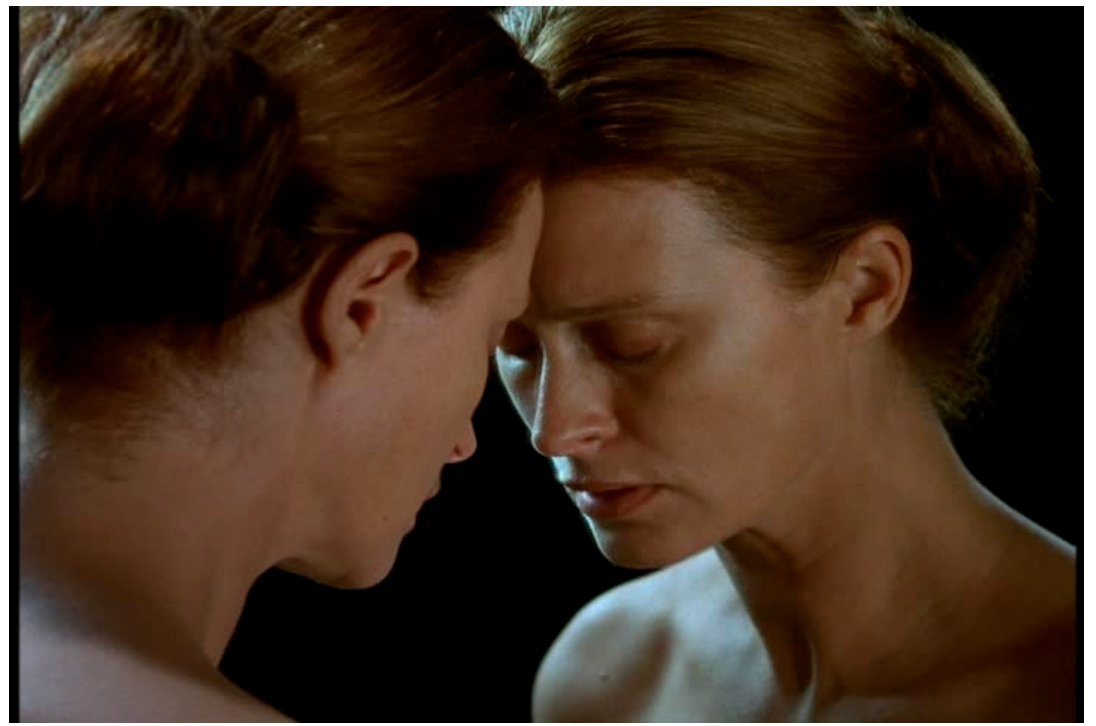
Figure 5. Marianne battles with herself, Isabelle in the midst.